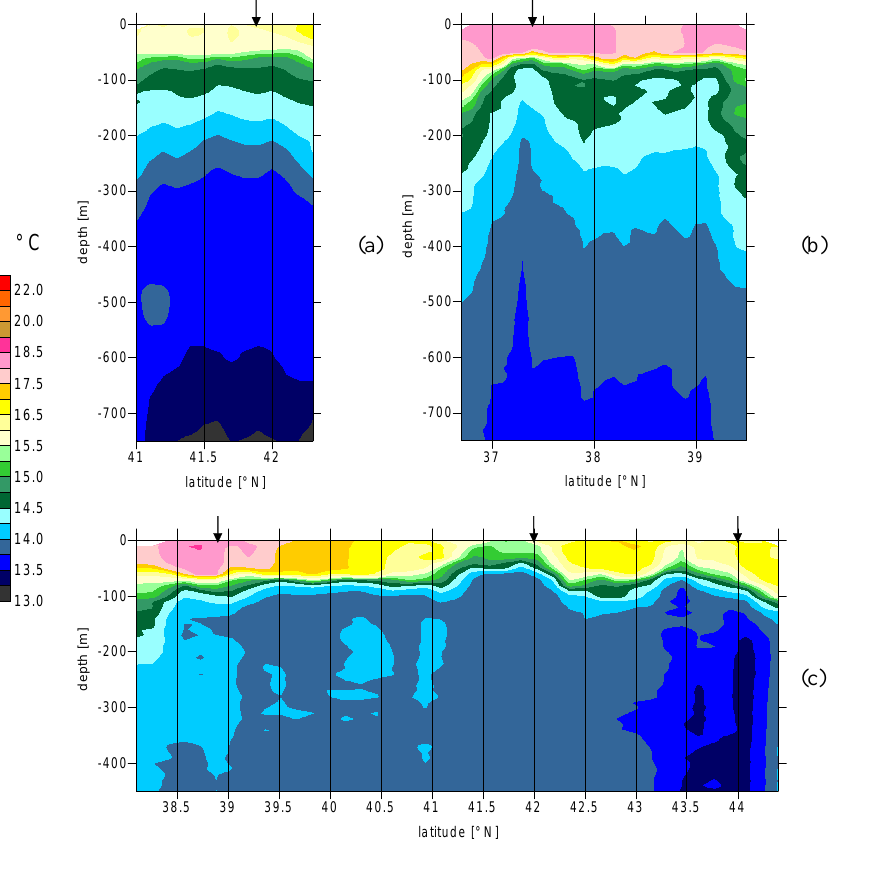
Fig. 2. Vertical sections at the be- ginning of December 1999: across the southern Adriatic (a) , across the NW Ionian Sea (b) and across the Ligurian- Tyrrhenian section (c) . Arrows denote position of the five XBT locations for temporal